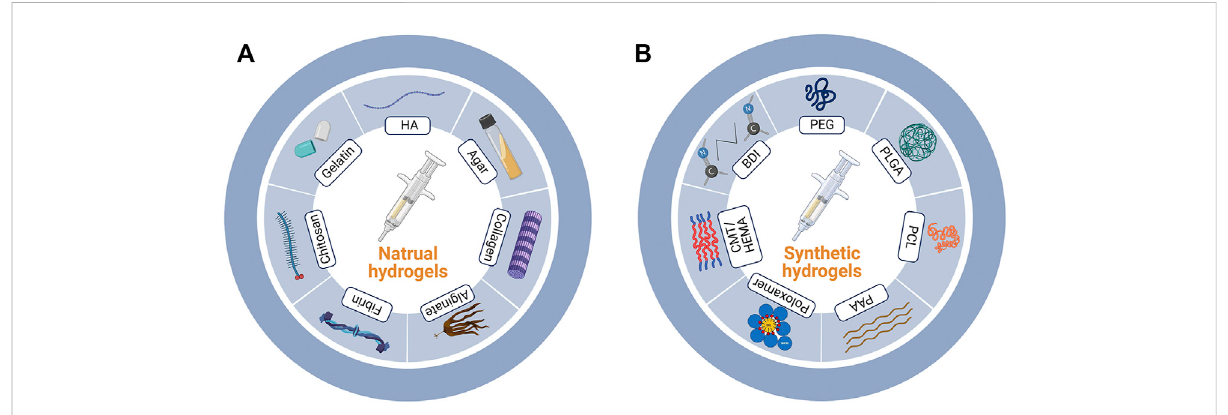
FIGURE 1 Nature-based and synthetic hydrogels. (A) Major components of nature-based and (B) synthetic hydrogels. HA, hyaluronic acid; PEG, polyethylene glycol; PLGA, poly (lactic-co-glycolic acid); PCL, polycaprolactone; PAA, polyacrylic acid; CMT/HEMA, carboxy methyl tamarind/ hydroxyethyl methacrylate; BDI, butane-diisocyanate.